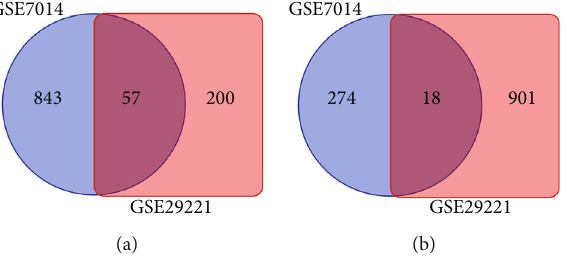
Figure 2: Identi fi cation of shared DEGs. (a) DEGs upregulated in both the GSE7014 and GSE29221 datasets. (b) DEGs downregulated in both the GSE7014 and GSE29221 datasets. Table 1: Functional and pathway enrichment analyses for module genes. The top 3 terms were selected based upon p value rankings when > 3 terms were enriched for a given